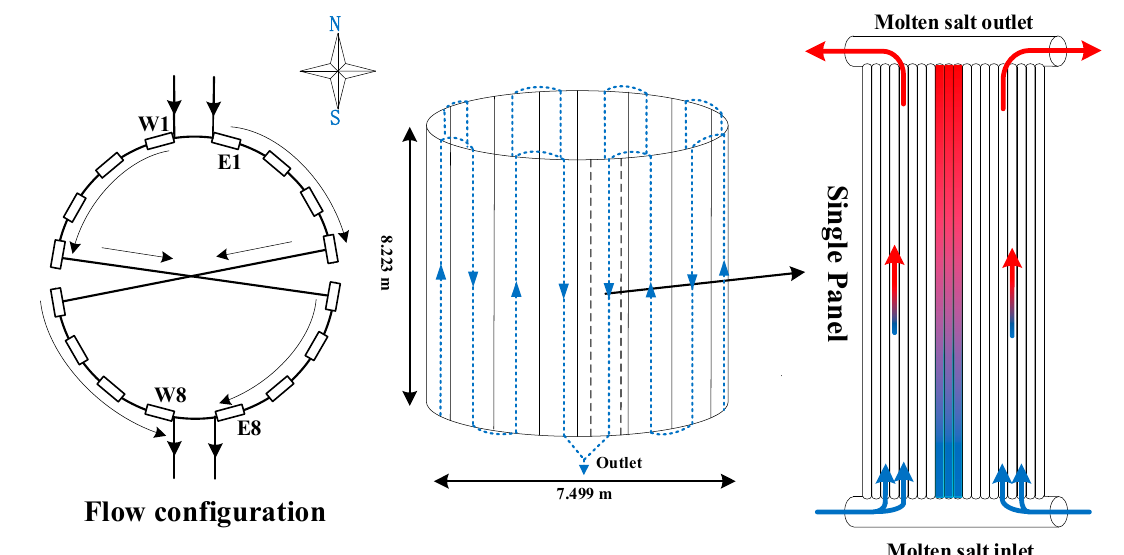
Figure 1. The flowchart of the external receiver structure. Table 1. Receiver parameters.